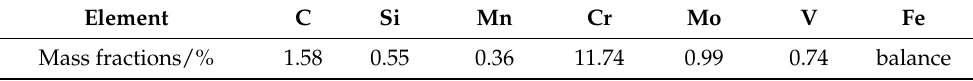
Table 1. Chemical composition of the high-alloy tool steel X153CrMoV12 determined by OES.